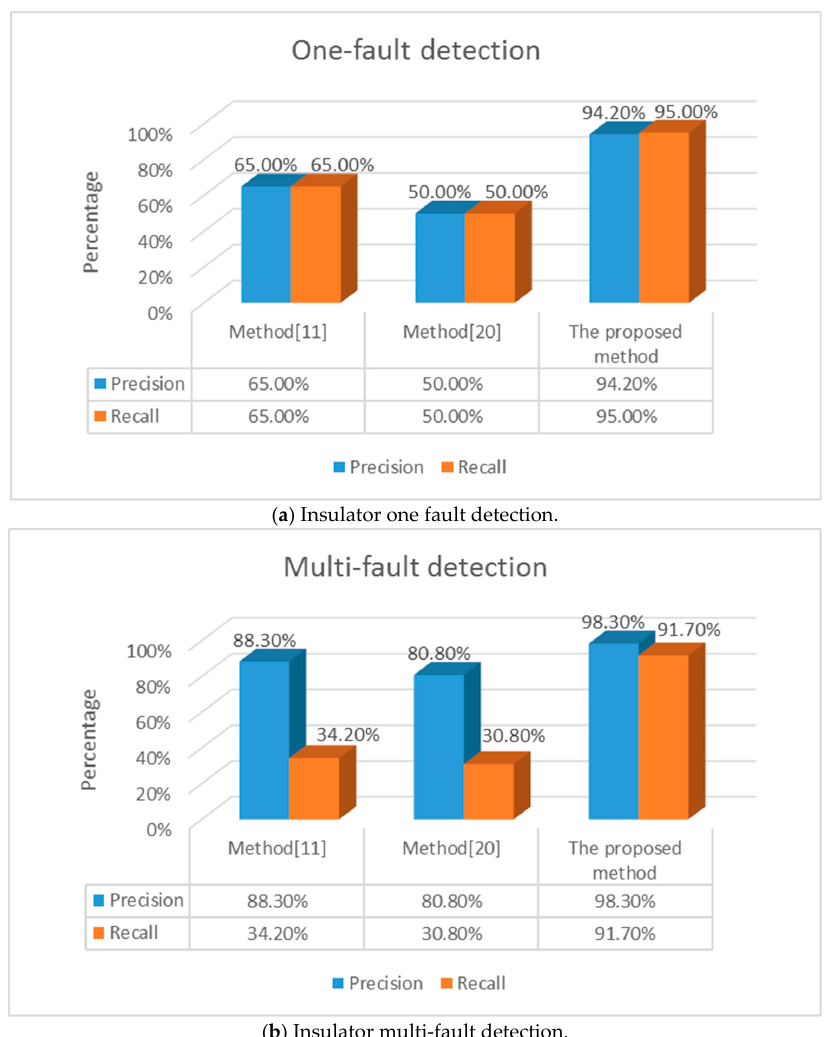
Figure 11. The detection performances of the proposed method and two compared methods on 60 insulator one fault images and 60 multi-fault images. The proposed method not only achieves high precision rates, but also maintains satisfactory recall rates.